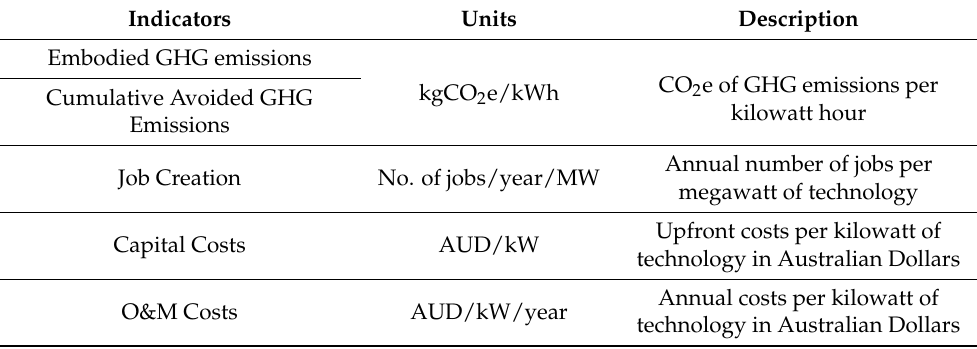
Table A2. The descriptions of the indicators.